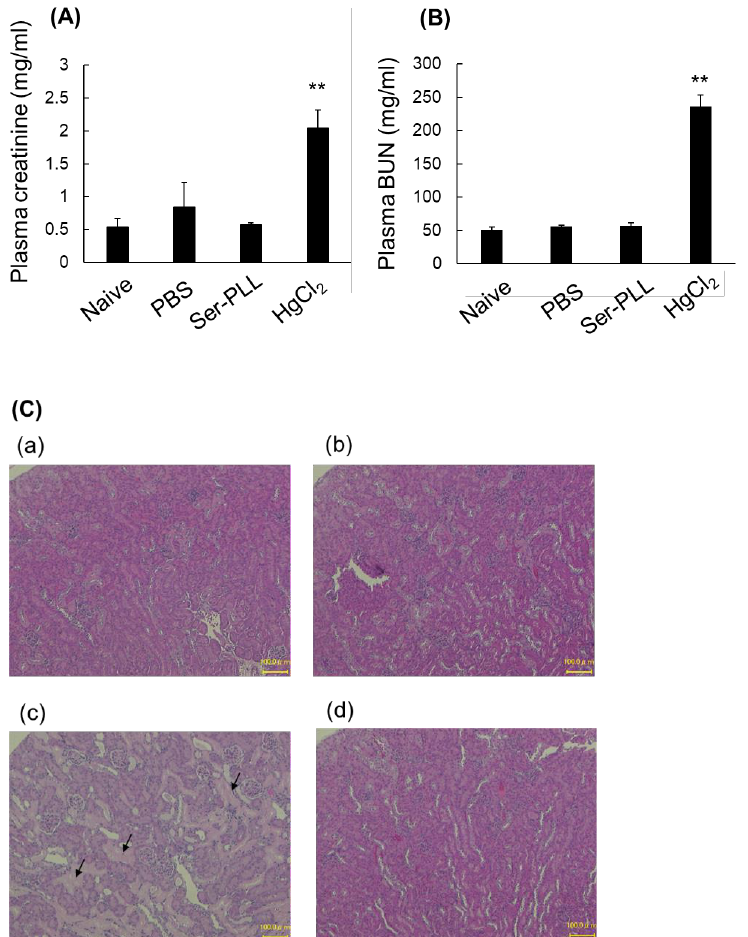
Figure 5. Plasma creatinine ( A ) and BUN ( B ) levels after continuous intravenous Ser-poly-L-lysine (Ser-PLL) injection for 5 d. Data are means ± SE for ≥ three mice. ** statistically significant difference compared with the naïve group ( p < 0.01). ( C ) Histological examination of kidneys of mice in the naïve group ( a ), PBS ( b ), HgCl 2 ( c ), and Ser-poly-L-lysine (Ser-PLL) ( d ). (scale bar = 100 μm) .